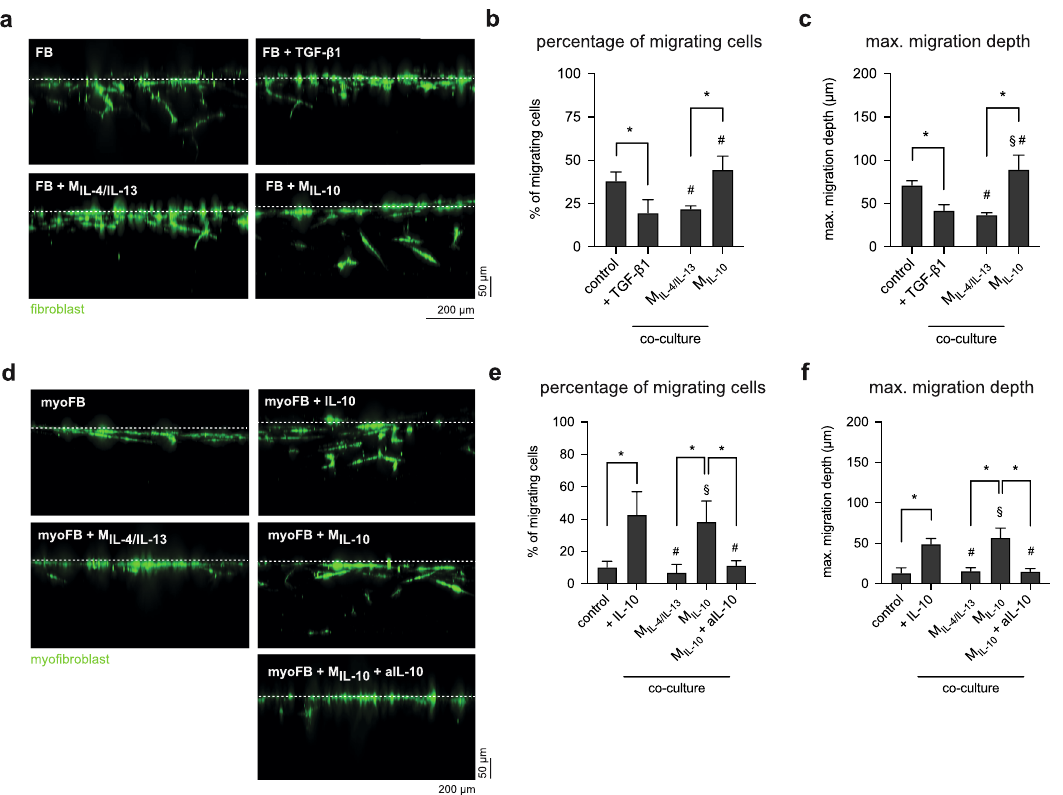
Fig. 8 Migration of fi broblasts and myo fi broblasts into 3D collagen matrices. Cells were stained with Phalloidin conjugated with Alexa Fluor-488 and DAPI, for visualization and quanti fi cation of cell migration into 3D collagen matrices, respectively. Representative images of xz - view of a fi broblast and d myo fi broblast into 3D collagen matrices in mono- and co-culture with macrophages. Quantitative analysis of b , e percentage of migrating cells and c , f maximum migration depth of fi broblast and myo fi broblasts. Cells found >20 μ m beneath the matrix surface were counted as migrating cells. The maximum migration distance was de fi ned as the distance crossed by 10% of all cells. Data are represented as mean ± SD; *signi fi cance level of p ≤ 0.05 using a one-way ANOVA followed by Tukey ’ s post hoc analysis. The characters # and § represent the signi fi cance level of p ≤ 0.05 using a one-way ANOVA followed by Tukey ’ s post hoc analysis when compared to control, and treated samples with TGF- β 1 or IL-10, respectively. Three different positions of each matrix condition were analyzed. Experiments were performed in four